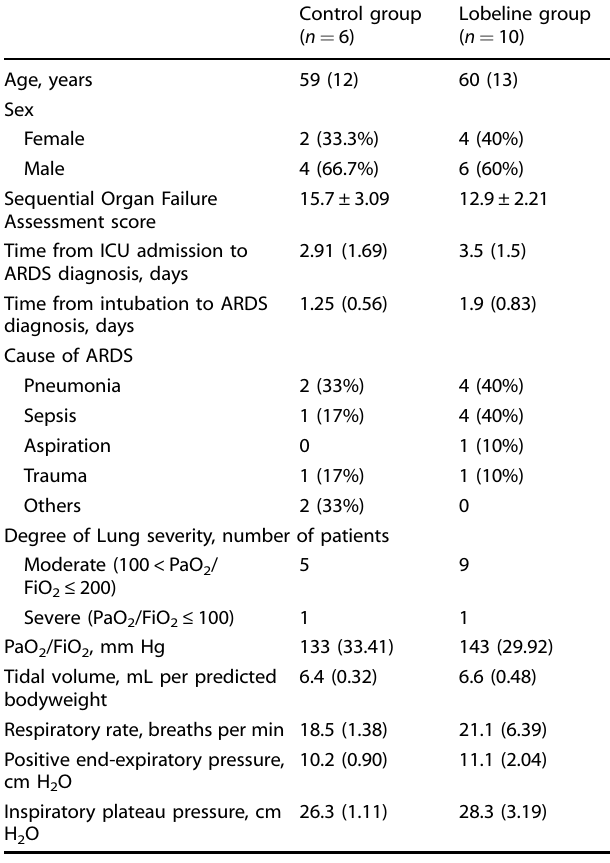
Table 1. Characteristics of the patients from control and lobeline